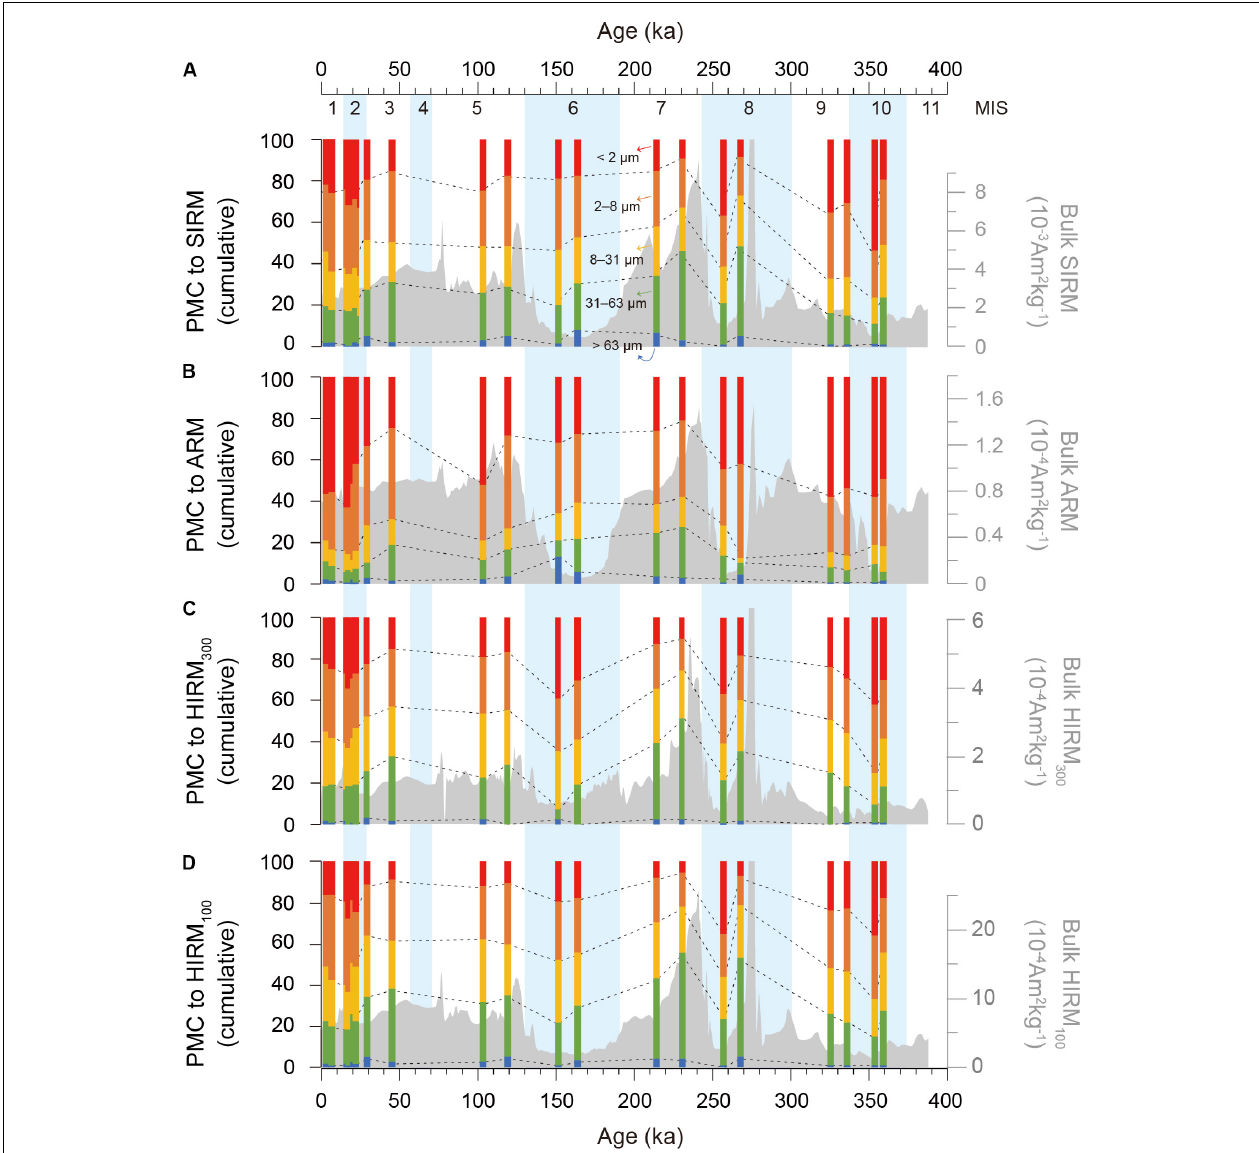
FIGURE 3 | Percentage magnetic contribution (PMC) of the size-fractionated samples to bulk magnetic parameters of (A) SIRM, (B) ARM, (C) HIRM 300 , and (D) HIRM 100 . PMC of each fraction is illustrated as cumulative bar chart. The color index is the same as in Figure 2